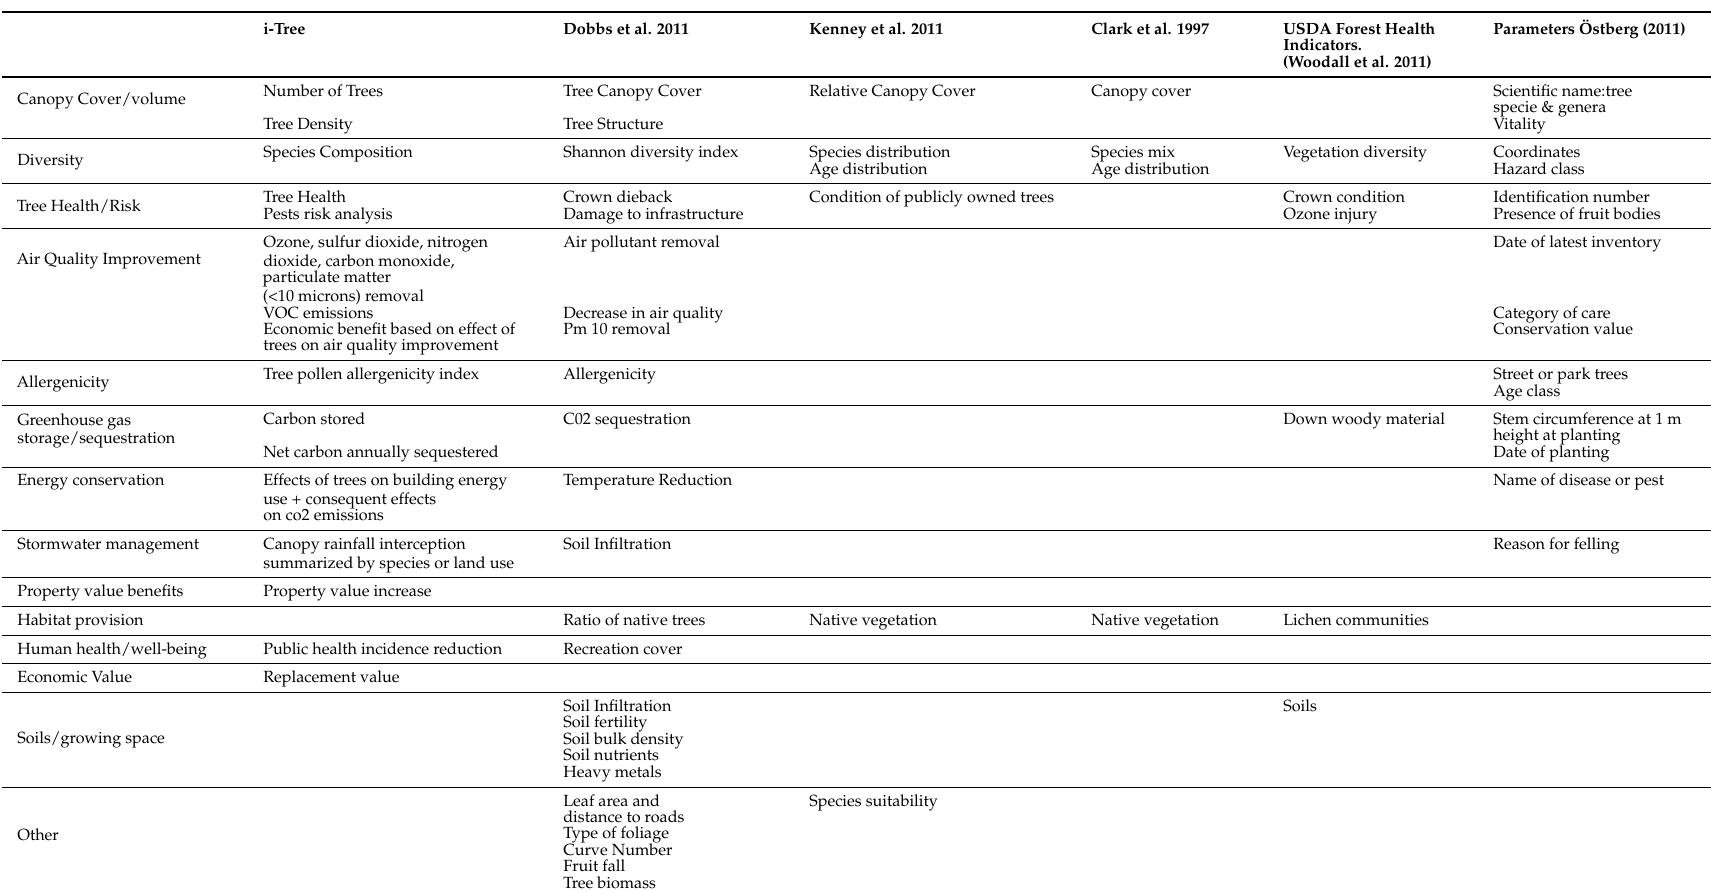
Table A1. Existing Urban Forest Indicator